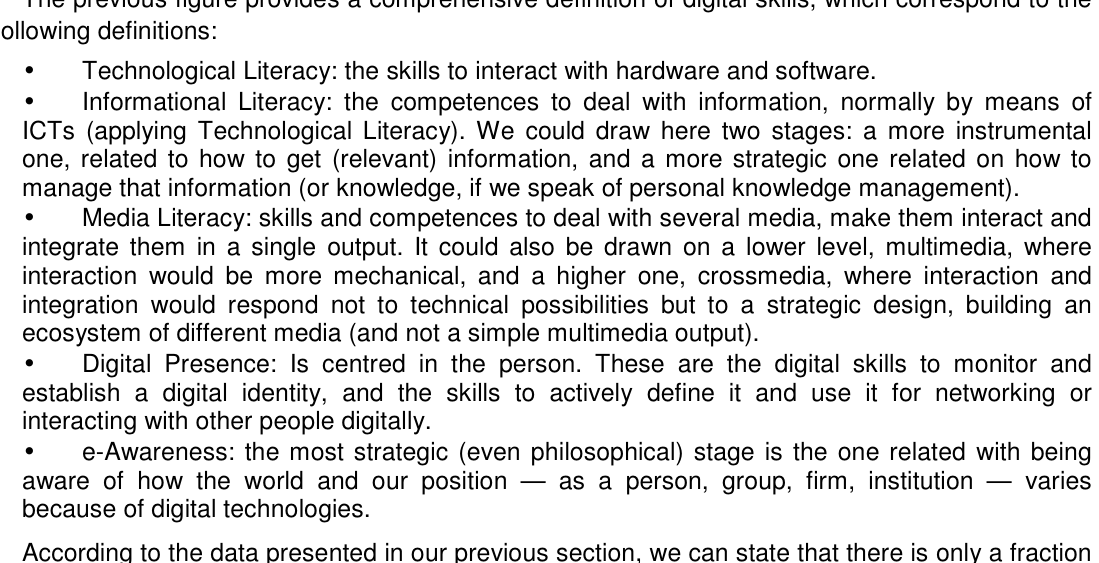
Figure 4: Towards a comprehensive definition of digital skills (Peña-López,